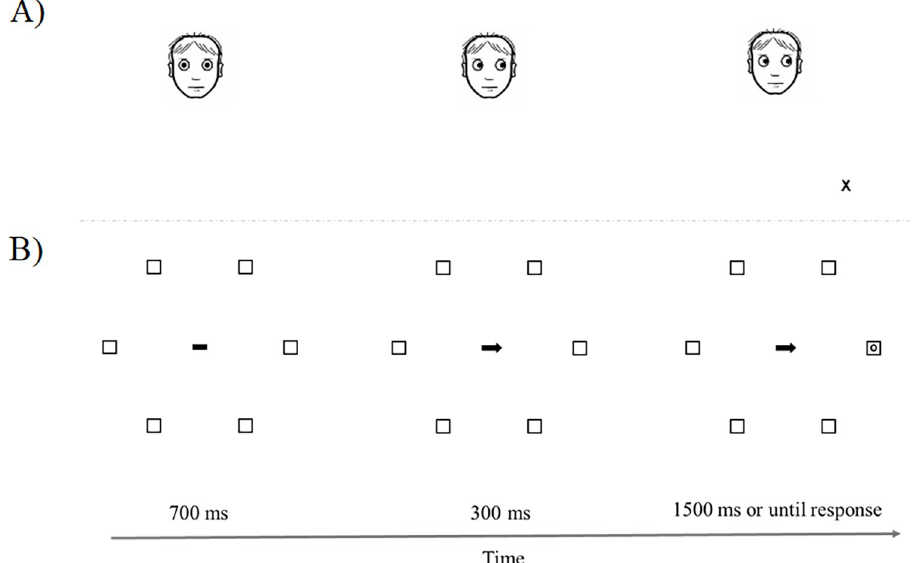
Fig 1. Schematic view of a trial sequence for both the gaze cue and the arrow cue conditions. The example represents: A) gaze-cue/placeholder-absent/same-hemifield condition, and B) arrow-cue/placeholder-present/same- location/same-hemifield